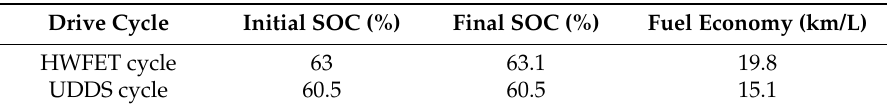
Table 3. Drive cycle simulation